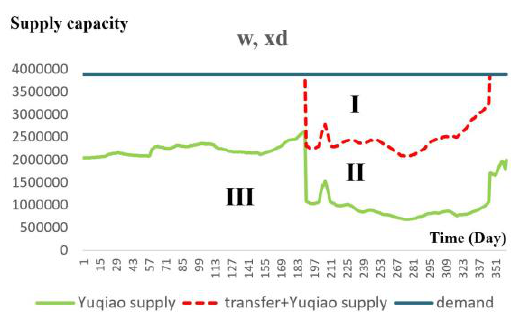
Figure 12. Case of ( m , xd ).